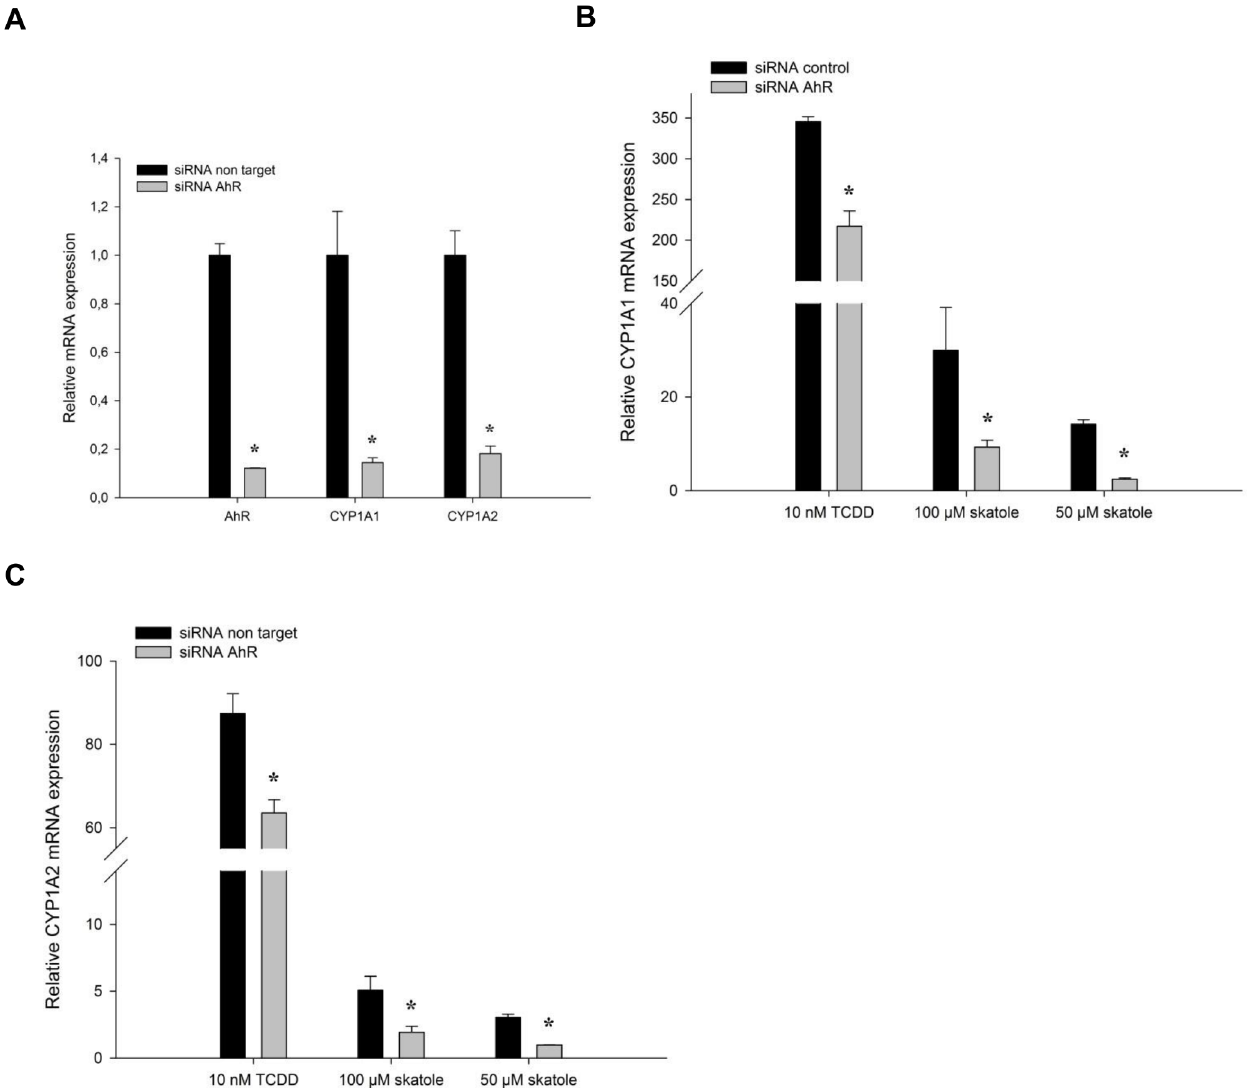
Fig 3. AhR is required for skatole-mediated CYP1A1 and CYP1A2 up-regulation. (A) RT-qPCR analysis of AhR , CYP1A1 and CYP1A2 mRNA expression in PHHs (Donor #391) after siRNA-mediated AhR down-regulation. (B) RT-qPCR analysis of CYP1A1 (B) and CYP1A2 (C) mRNA expression in PHHs after siRNA-mediated AhR down-regulation and incubation with 50 or 100 μ M skatole, or 10 nM TCDD. * significantly different from cells transfected with non-target